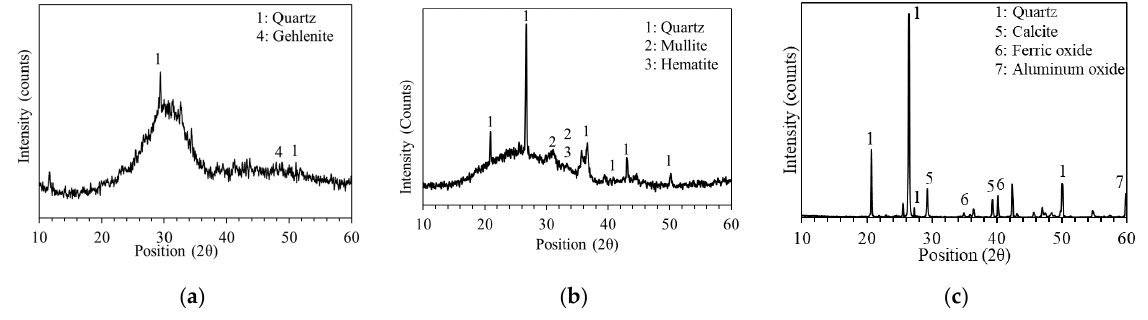
Figure 3. XRD patterns of ( a ) slag, ( b ) fly ash, and ( c ) dune sand.